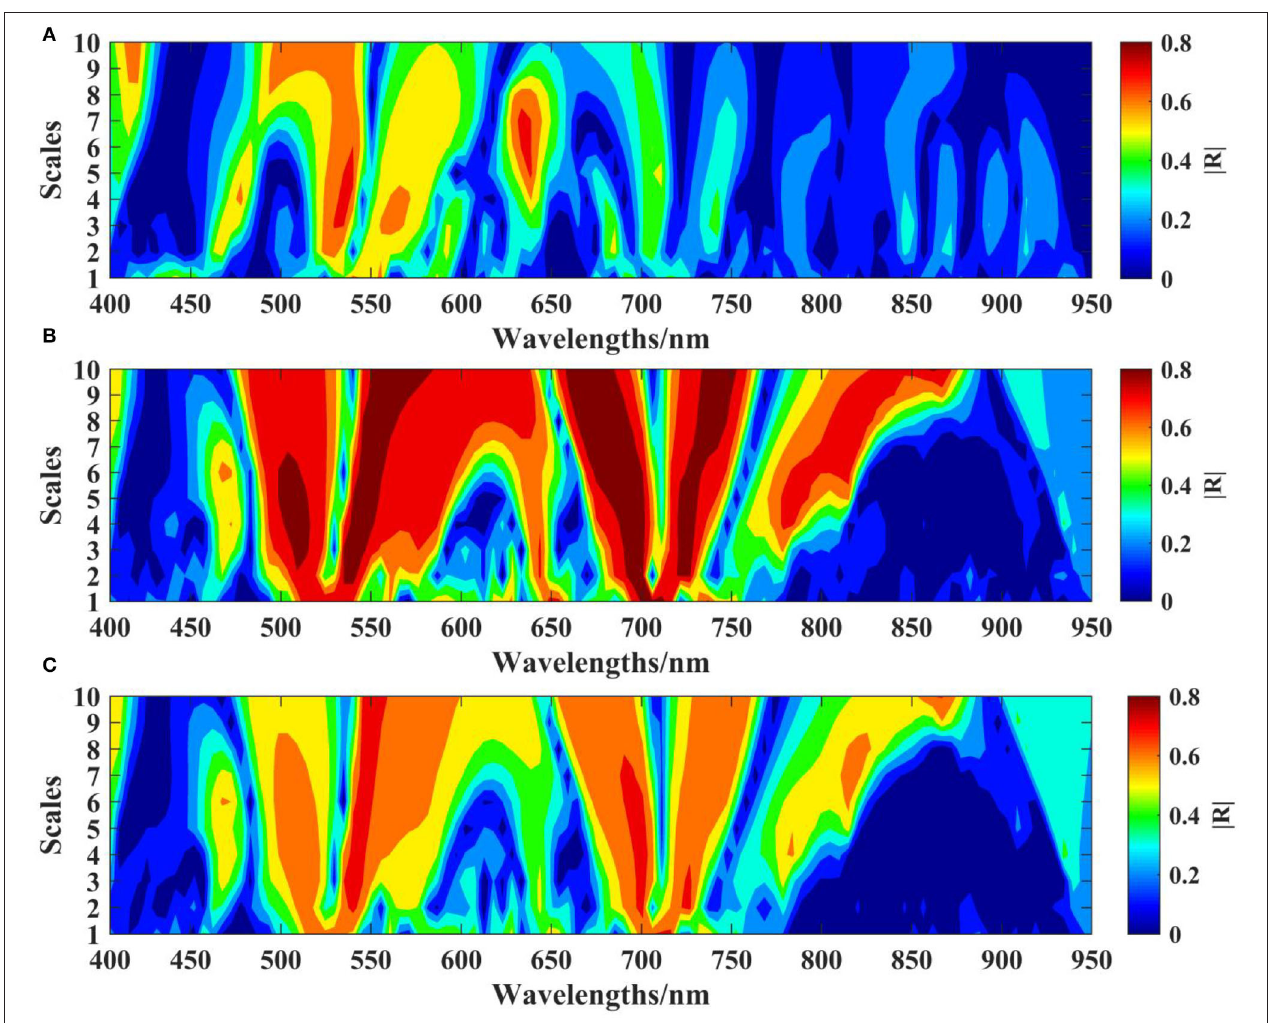
FIGURE 5 | Correlation analysis between the LKC and CWT coefficient. (A) Budding stage. (B) Flowering stage. (C) Boll setting